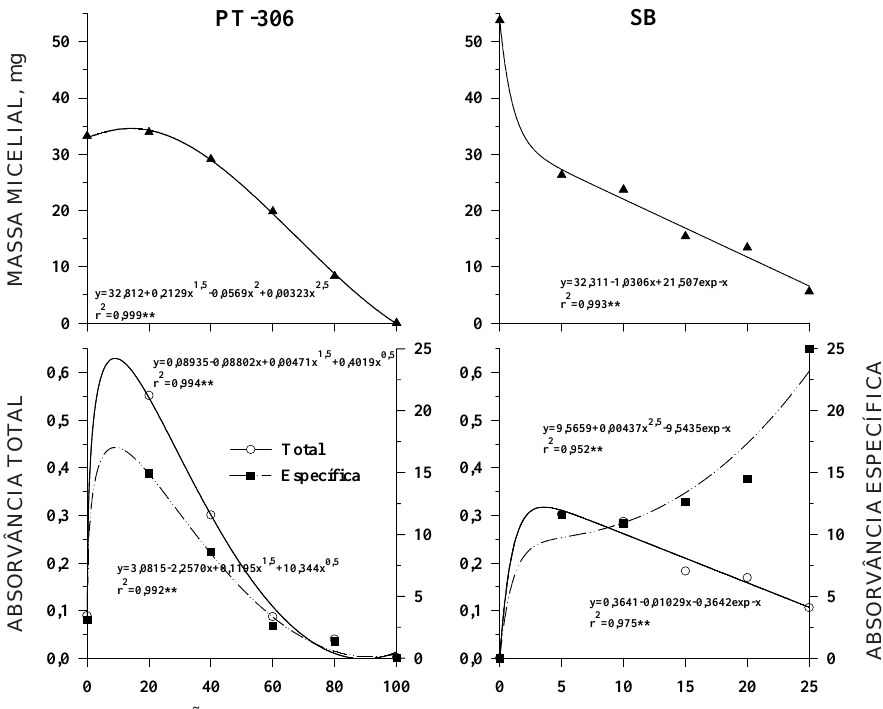
Figura 3. Crescimento (massa micelial), produção total de pigmentos extracelulares (Absorbância total a 350 nm) e produção específica de pigmentos extracelulares (Absorbância total/g de micélio seco) no meio de cultura do isolado PT-306 e do SB em meio MNM que continha mistura de solo e areia com diferentes proporções de solo com contaminação múltipla por metais